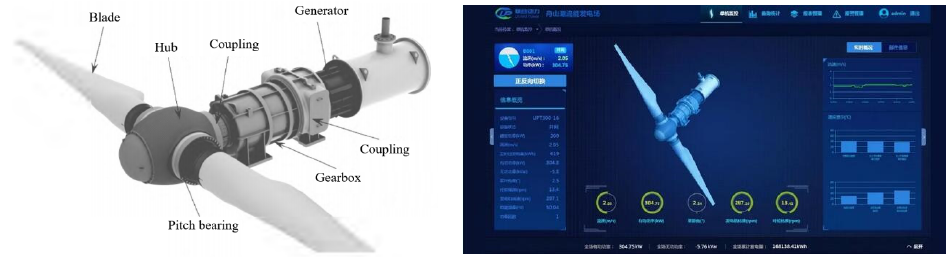
Figure 20. Model of 300 kW TCPGS. Reproduced from [58,59].